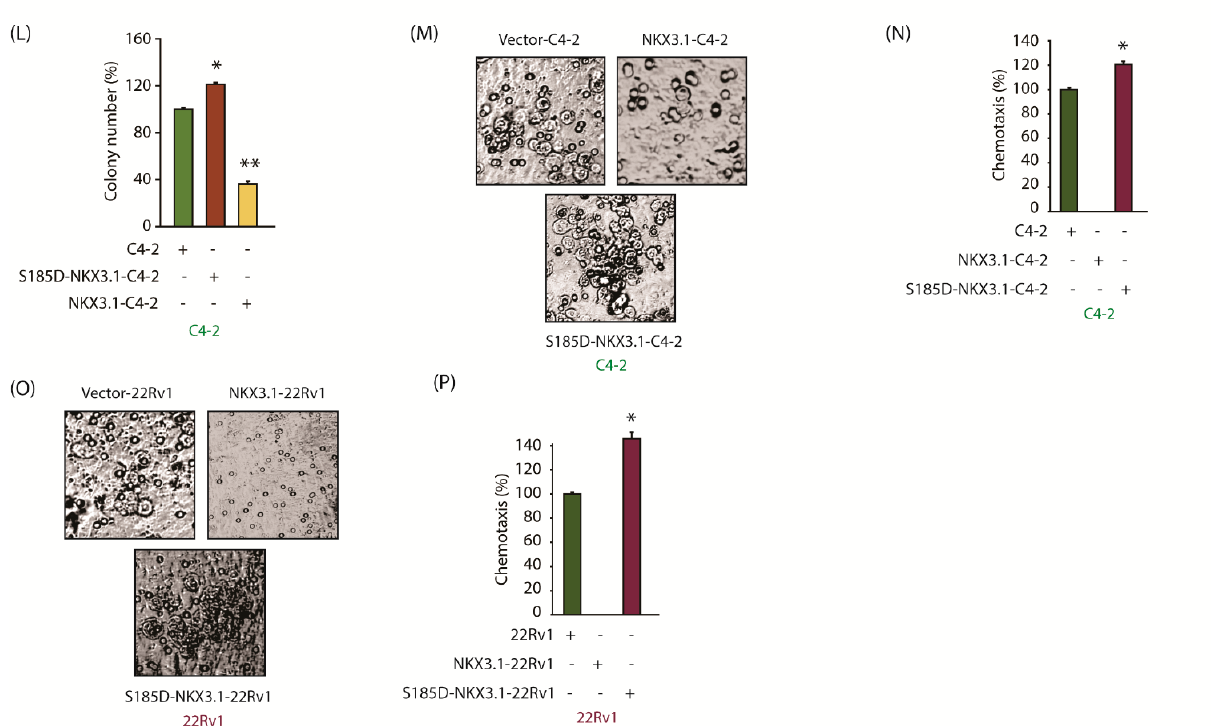
Figure 6. Phospho-mimetic S185D-NKX3.1 is less stable and promotes oncogenic phenotypes. ( A ) S185D-NKX3.1 is expressed at a lower level compared to the wild-type-NKX3.1. C4-2 cells were transiently infected with NKX3.1 and S185D-NKX3.1 retroviruses. Cell lysates were analyzed to detect NKX3.1 and LIMK2 protein levels; ( B ) Quantification of LIMK2 and NKX3.1 levels normalized to actin is shown from three independent experiments. * p < 0.05; ( C ) S185D-NKX3.1 is expressed at a lower level compared to the wild type in 22Rv1 cells; ( D ) Quantification of LIMK2 and NKX3.1 levels normalized to actin is shown from three independent experiments. * p < 0.05 and ** p < 0.01; ( E ) The stability of LIMK2 is increased due to S185D mutation in NKX3.1. LIMK2 degradation in C4-2 cells was tested using CHX; ( F ) Quantification of LIMK2 levels normalized to actin is shown from three independent experiments. ** p < 0.01; ( G ) Stability of LIMK2 increases in S185D-NKX3.1-22Rv1 cells; ( H ) Quantification of LIMK2 levels normalized to actin is shown from three independent experiments. ** p < 0.01; ( I ) S185D expression in C4-2 cells inhibits the ubiquitylation of LIMK2; ( J ) Cell viability was measured at indicated times in C4-2 and ( K ) 22Rv1 cells treated with vector, NKX3.1 and S185D-NKX3.1 retroviruses. Target cells were seeded in a 24-well plate and infected using vector, NKX3.1 and S185D-NKX3.1 retroviruses. All data are from three independent experiments. ** p < 0.01 and *** p < 0.001; ( L ) NKX3.1 suppressed colony formation in C4-2 cells. Stable C4-2 cells expressing either NKX3.1 or S185D-NKX3.1 were used for colony formation assay. The colony formation data are plotted as the means ± SD of three independent experiments. * p < 0.05 and ** p < 0.01; ( M ) While WT NKX3.1 suppressed cell migration, S185D-NKX3.1 increased it in C4-2 cells; ( N ) The chemotaxis results in C4-2 cells are plotted as the means ± SD of three independent experiments. * p < 0.05; ( O ) While WT NKX3.1 suppressed cell migration, S185D-NKX3.1 increased it in 22Rv1 cells; ( P ) The chemotaxis results obtained from 22Rv1 cells are plotted as the means ± SD of three independent experiments. * p <